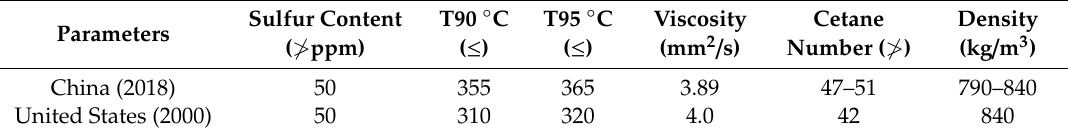
Table 1. Summary of diesel quality in the United States and China.